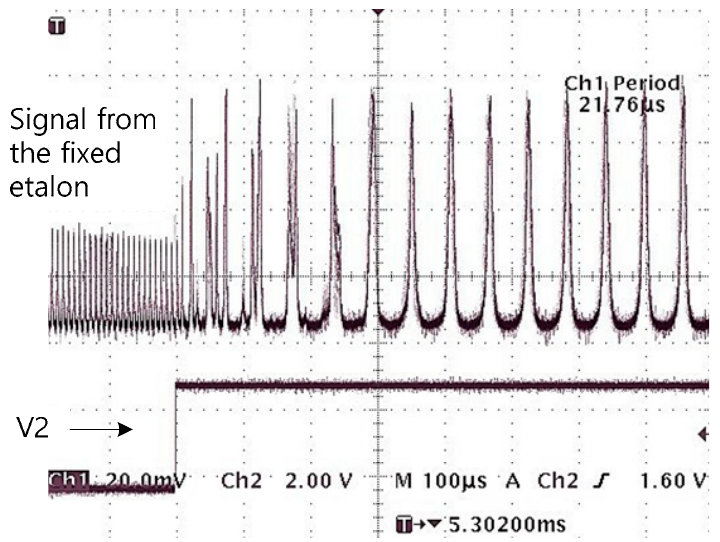
Figure 7. Output of the fixed etalon (top trace) and V2. It was observed that the waveform was not established yet for the first 300 μ s.